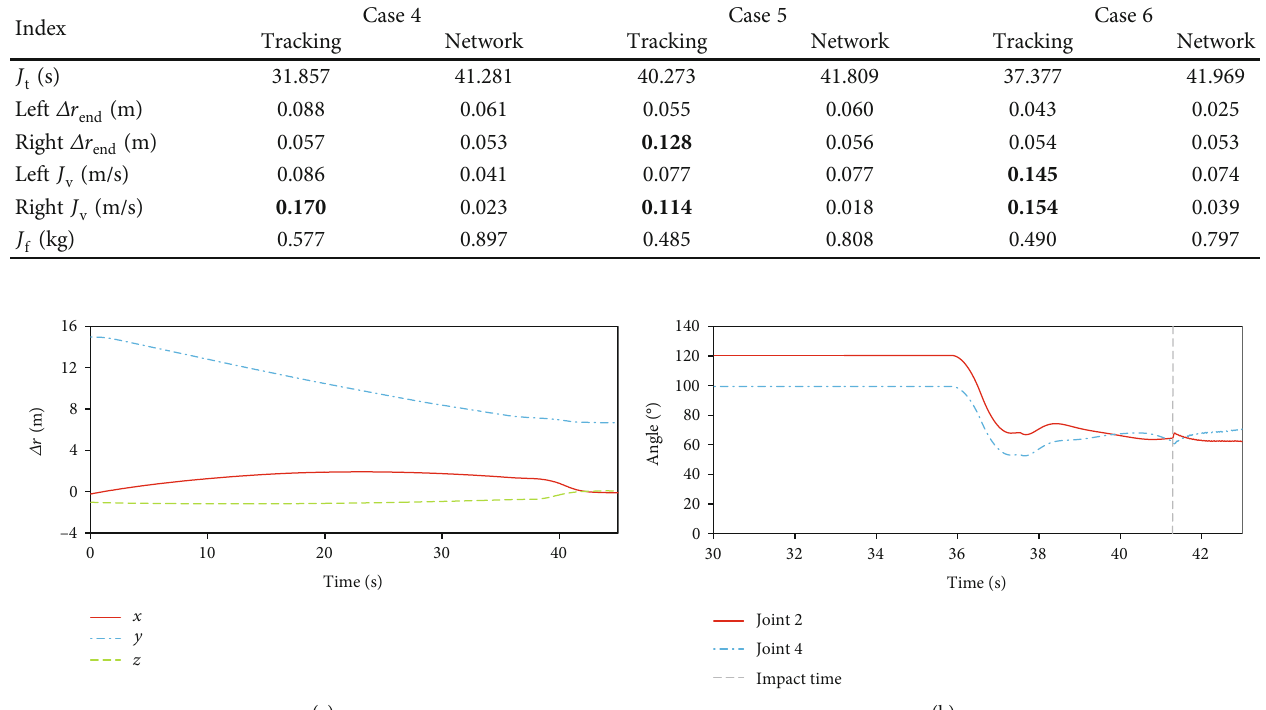
tb . (b) Angles of joint 2 and joint